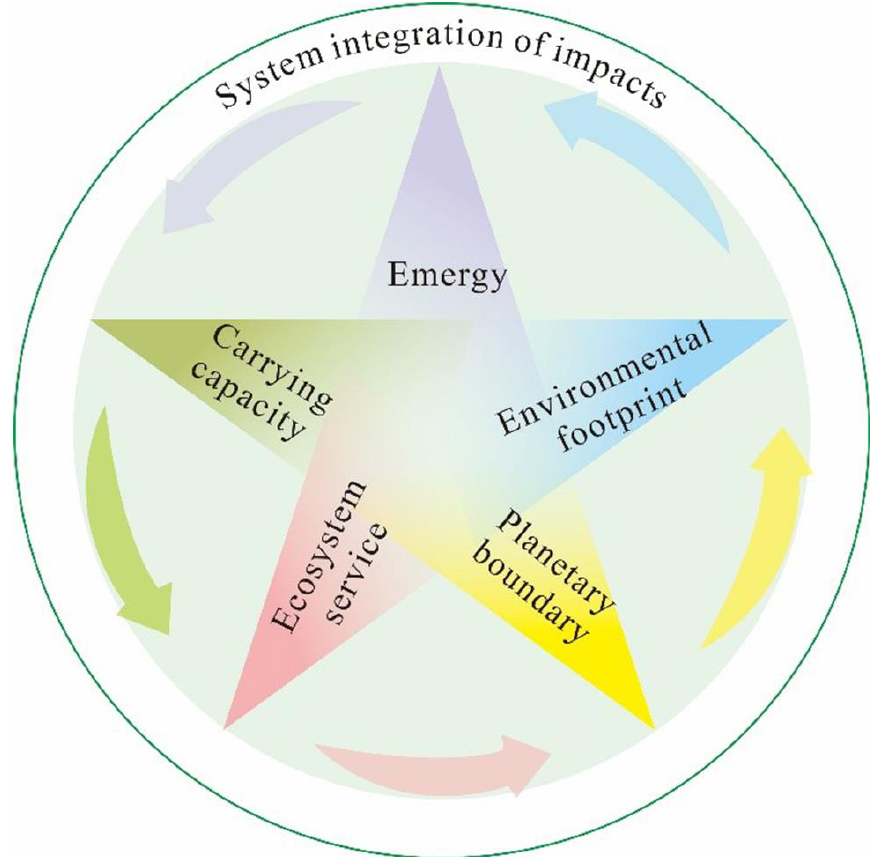
Figure 2. System integration of impacts from telecoupling. Notes: ecosystem services, emergy, and environmental footprints, planetary boundaries, and carrying capacity can be applied to quantify the net impacts of telecoupling on land.